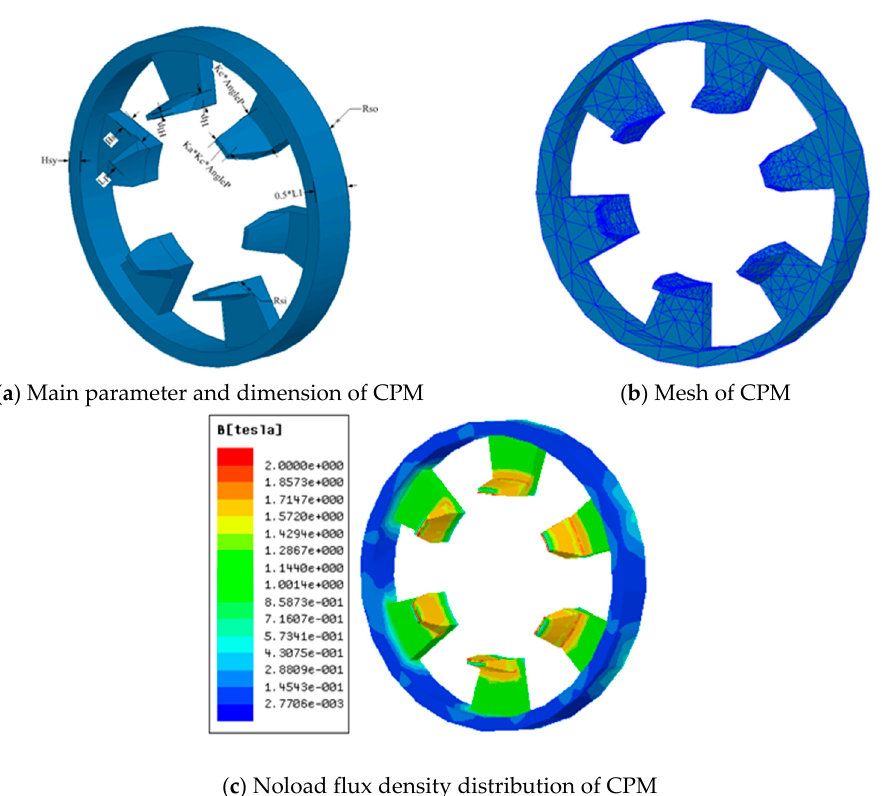
Figure 2. Machine topology of a claw pole machine with different numbers of pole pairs.